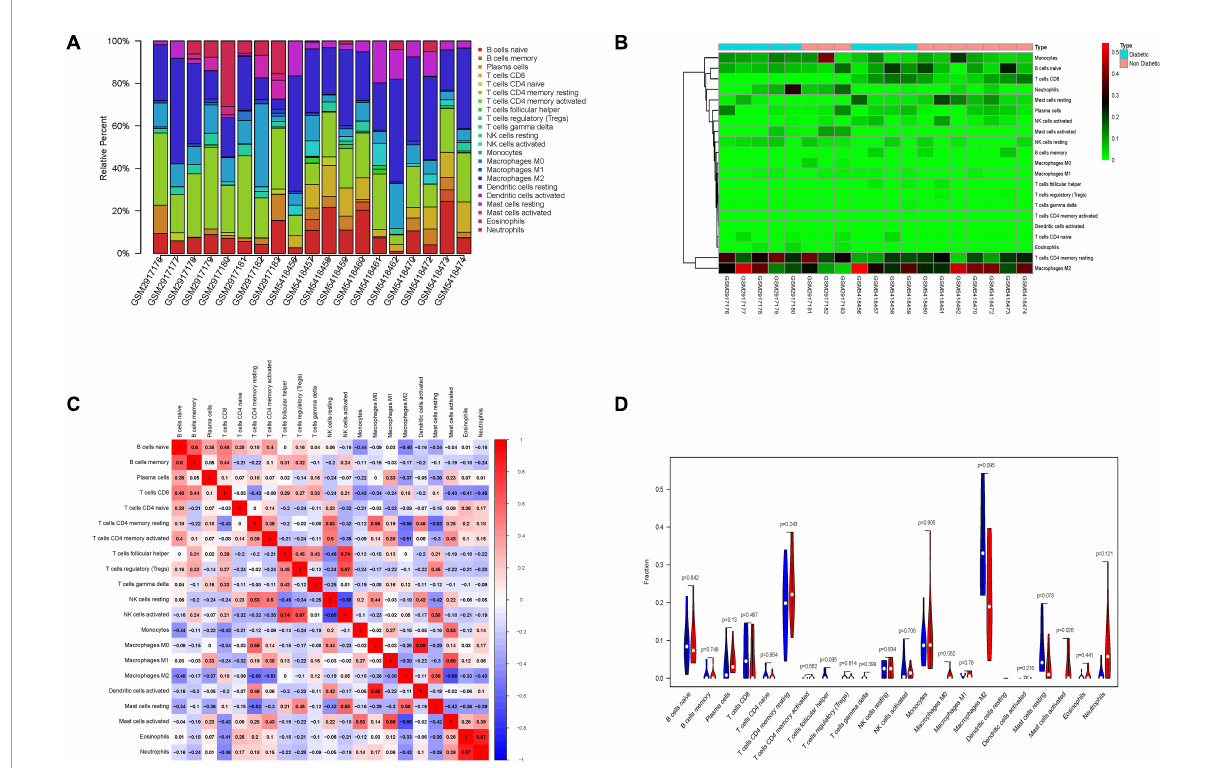
FIGURE6 Immune cells infiltration analysis of DEGs between diabetic and non-diabetic EAT using CIBERSORT. (A) The relative percentage of 21 immune cell types. (B) The heatmap of 21 subgroups of immune cells. (C) The correlation analysis among 21 immune cell types. (D) The difference in immune infiltration between diabetic and non-diabetic EAT samples. Blue columns represent non-diabetic group; red columns represent the diabetic group.